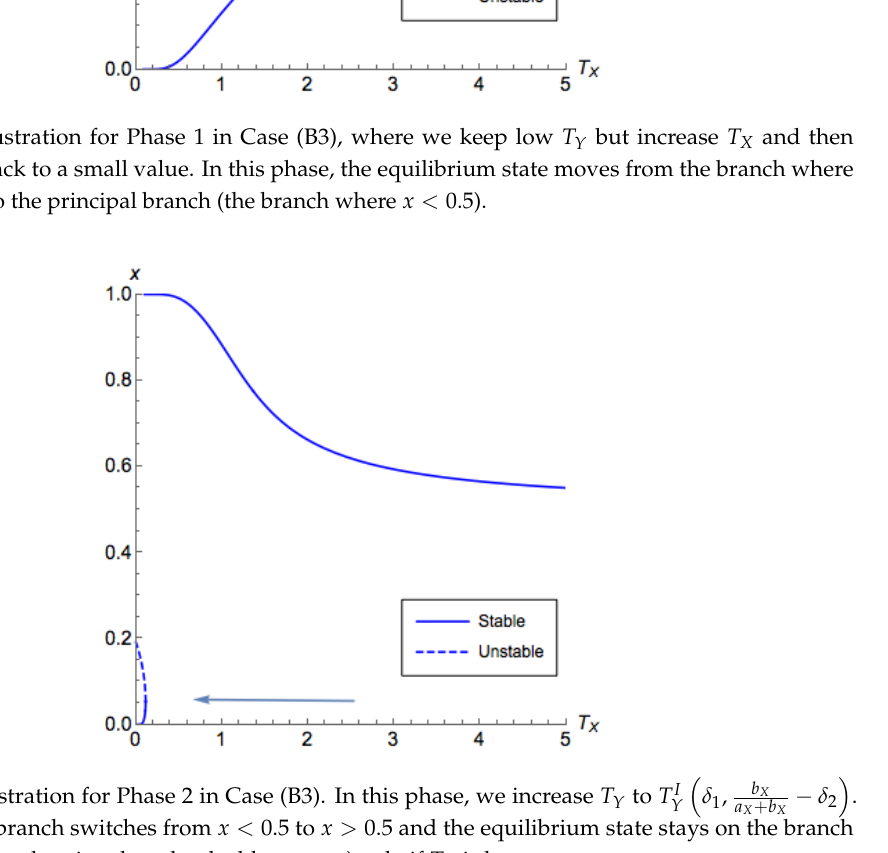
Figure 12. Illustration for Phase 2 in Case (B3). In this phase, we increase T Y to T I The principal branch switches from x < 0.5 to x > 0.5 and the equilibrium state stays on the branch x < 0.5 (the branch pointed out by the blue arrow) only if T X is